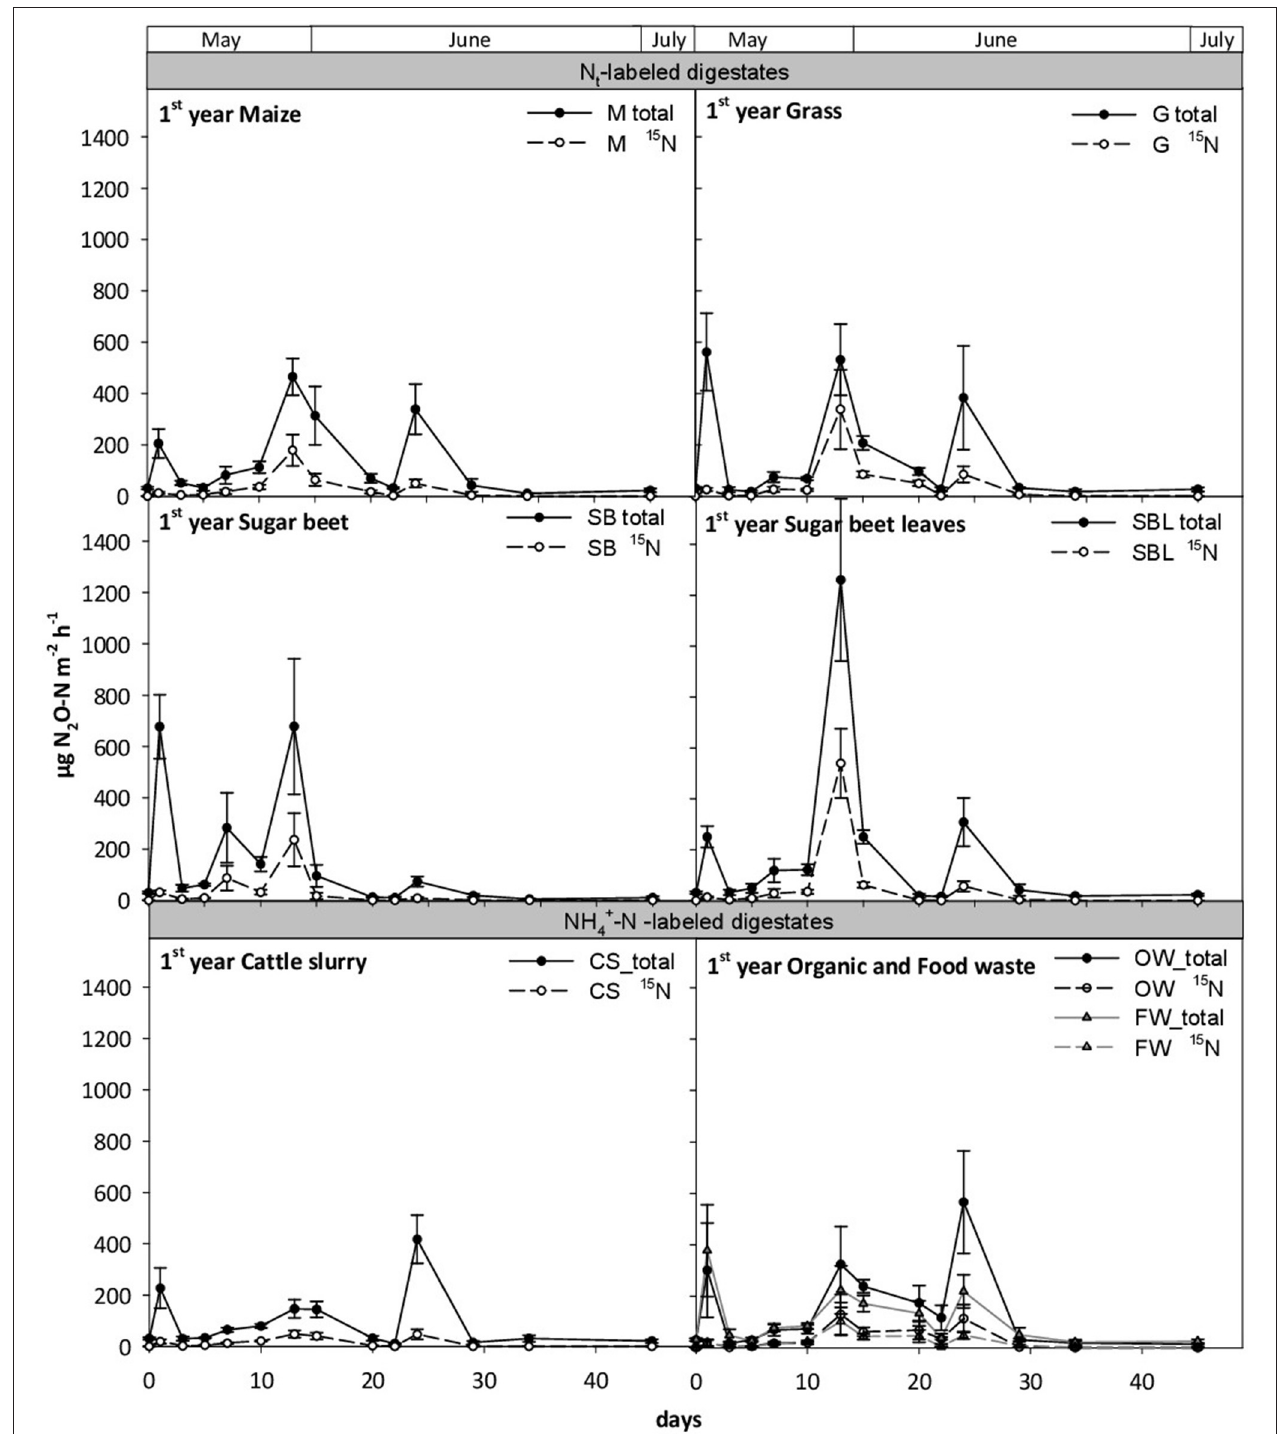
FIGURE 2 | Mean daily N 2 O fluxes (total) and digestate-derived 15 N-N 2 O fluxes ( 15 N) within the 1st year Digestates from maize (M), grass (G) sugar beet (SB), and sugar beet leaves (SBL) were 15 N t -labeled (mineral and organic N) and digestates based on cattle slurry (CS), organic waste (OW), and food waste (FW), were 15 N-labeled only in the NH + 4 -N pool. Error bars indicate the standard error ( n = 4).